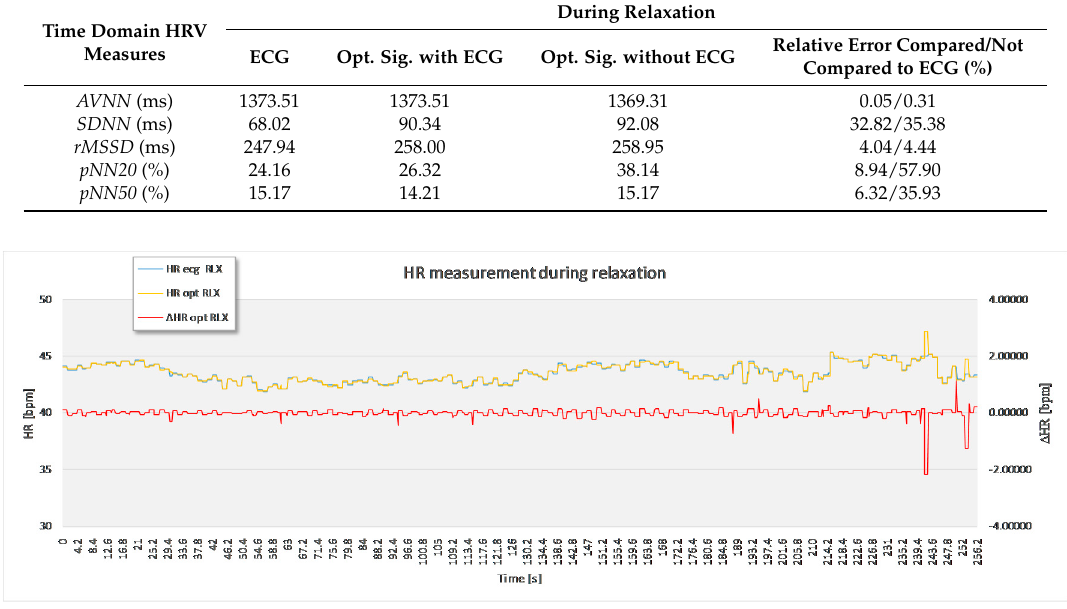
Figure 14. Sample of recorded signal on one of the patients in clinical environment.